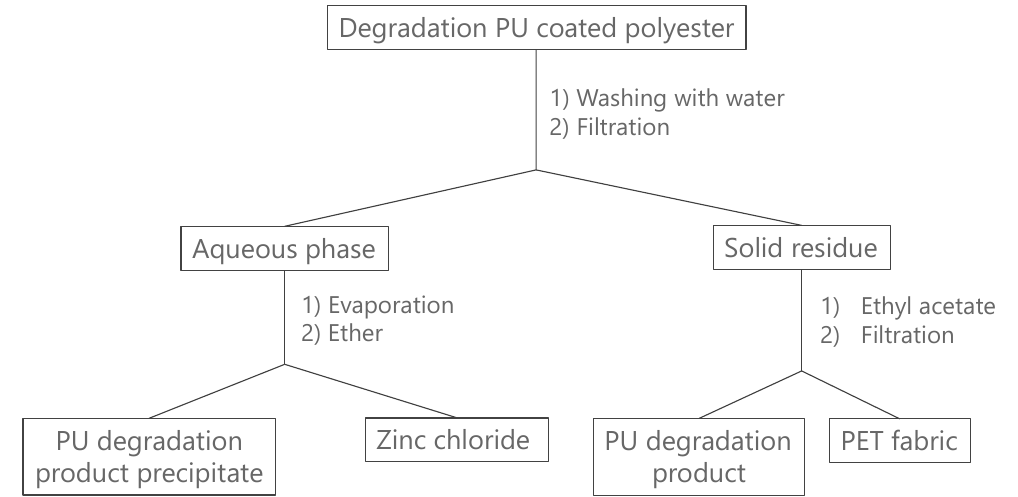
Figure 1. Flow chart of the degradation of PU-coated polyester and purification.